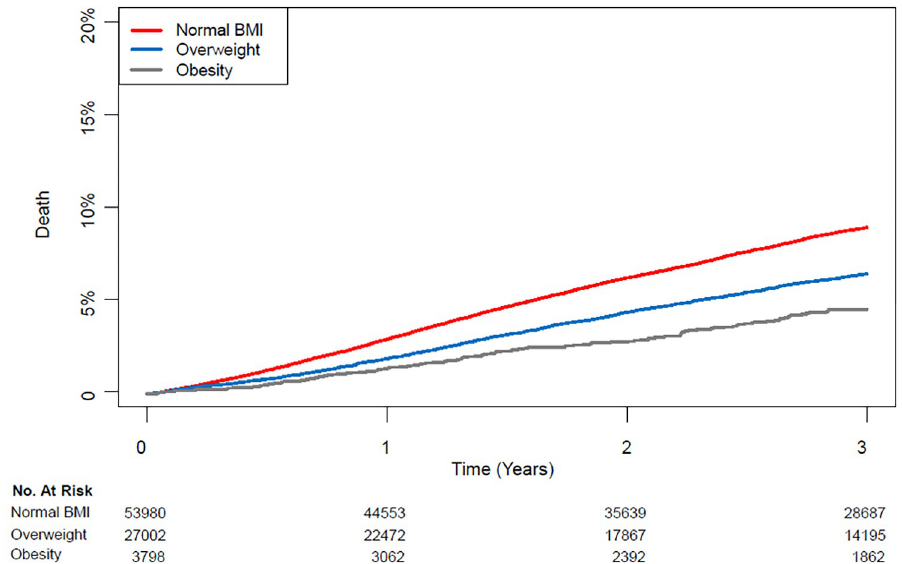
Fig 2. Kaplan–Meier curves of mortality of the normal, overweight, and obesity groups during three years after cancer surgery.